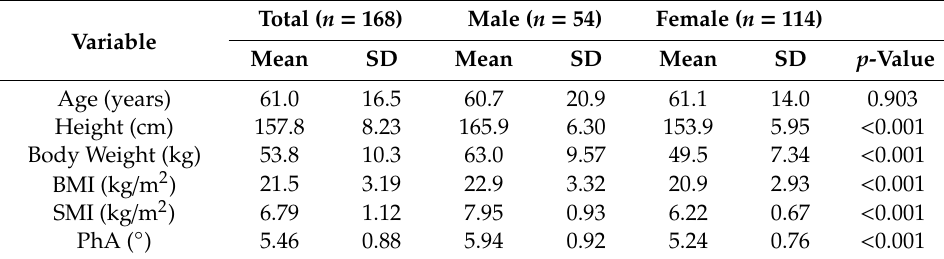
Table 1. A comparison of anthropometric measurements and PhA in males and females.